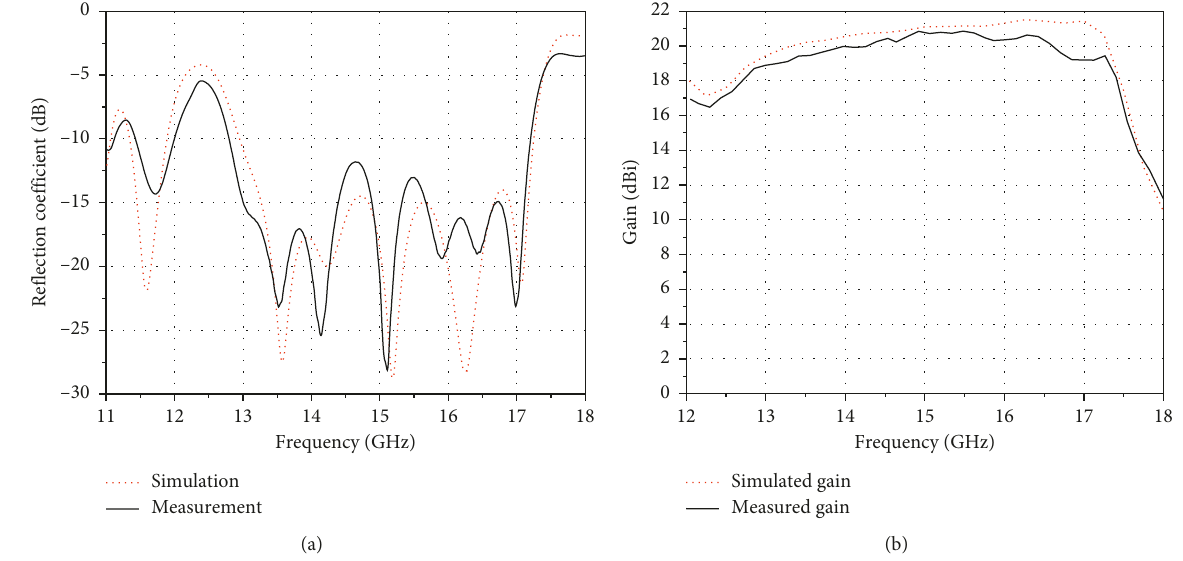
Figure 18: Simulated and measured S-parameters and gain of the antenna array. (a) Reflection coefficient. (b) Boresight gains.